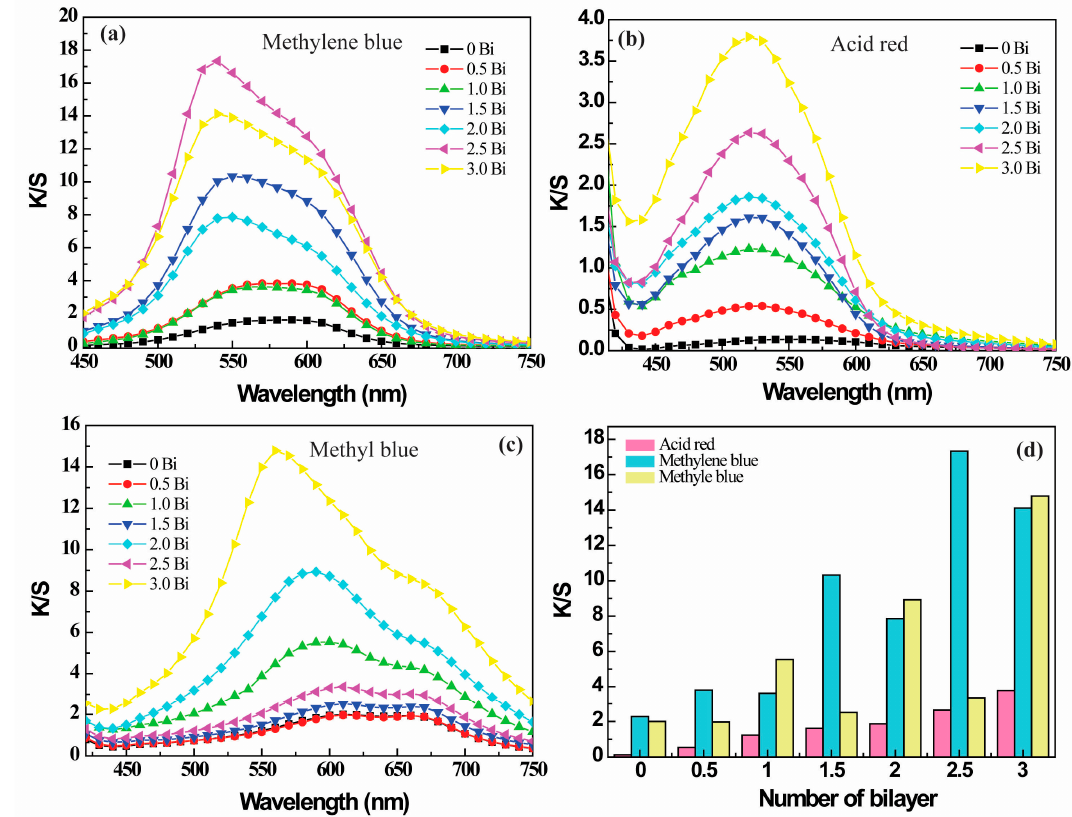
Figure 8. K/S profiles of different bilayer of PE-coated PET fabrics dyed with ( a ) methylene blue; ( b ) acid red; and ( c ) methyl blue; ( d ) K/S value of PE-coated PET fabrics as a function of the number of PE bilayer. (The surface of (PDADMAC/PAA) n -PET fabric was negatively charged when n = 0.5, 1.5, and 2.5. Alternatively, (PDADMAC/PAA) n -PET fabric was positively charged when n = 1, 2 and 3).